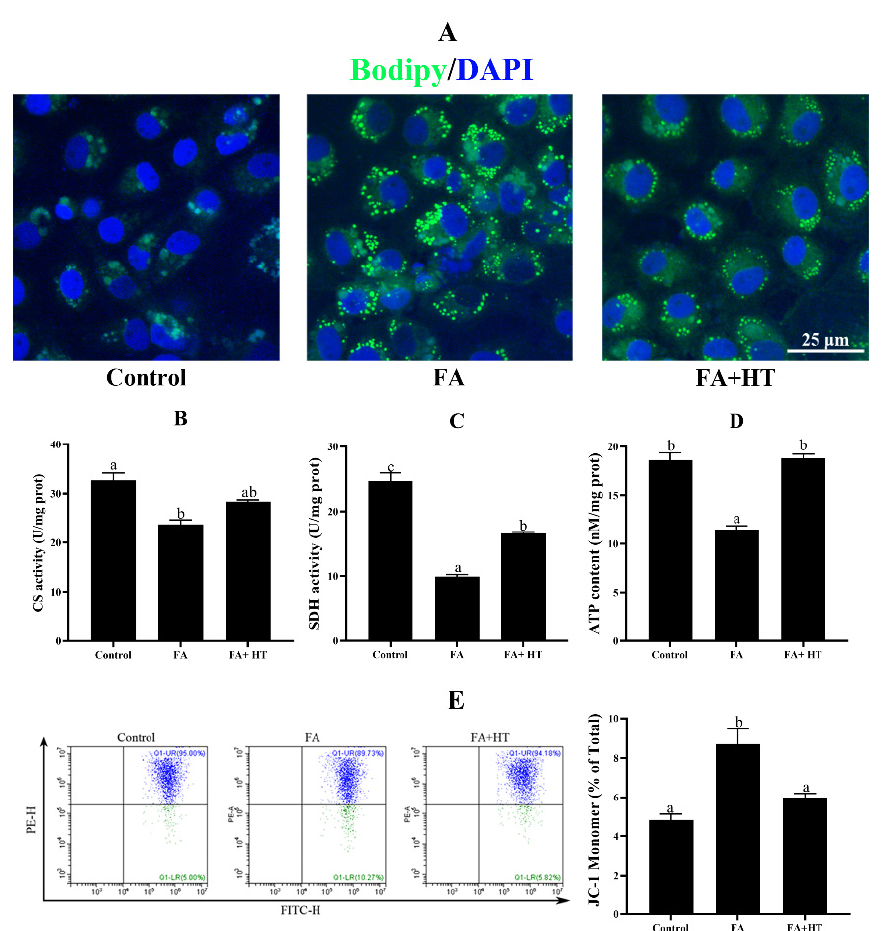
Figure 6. Staining of fat droplet by BODIPY 493/503 (green) in ZFL cell ( A ). Nuclei are highlighted with Hoechst 33342 (blue), scale bar = 25 µ m. Citrate synthase (CS: ( B )) and succinate dehydrogenase (SDH: ( C )) activities and ATP content (ATP: ( D )) in ZFL cell. Mitochondrial membrane potential (MMP) of ZFL cell was detected by the flow cytometer assessment of JC-1 staining ( E ). The ratio of JC-1 monomer is shown. Control group—complete LDF medium; FA group—FA medium (complete LDF medium with 0.25 mM oleic acid and 0.25 mM palmitic acid); FA + HT group—FA medium containing 50 µ M of HT. All values are exhibited as mean ± SE. The values with different superscripts (a, b, c) are significantly different at p < 0.05 (Tukey’s test).